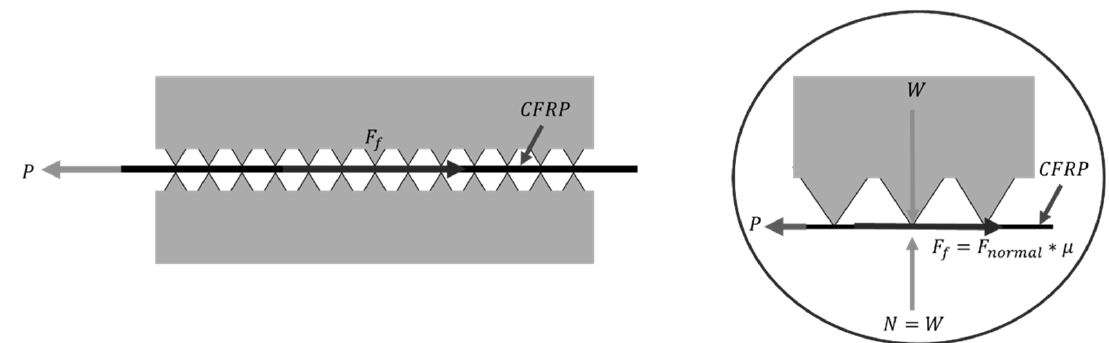
Figure 16. Cross-section view of retrofit friction grip mechanism.